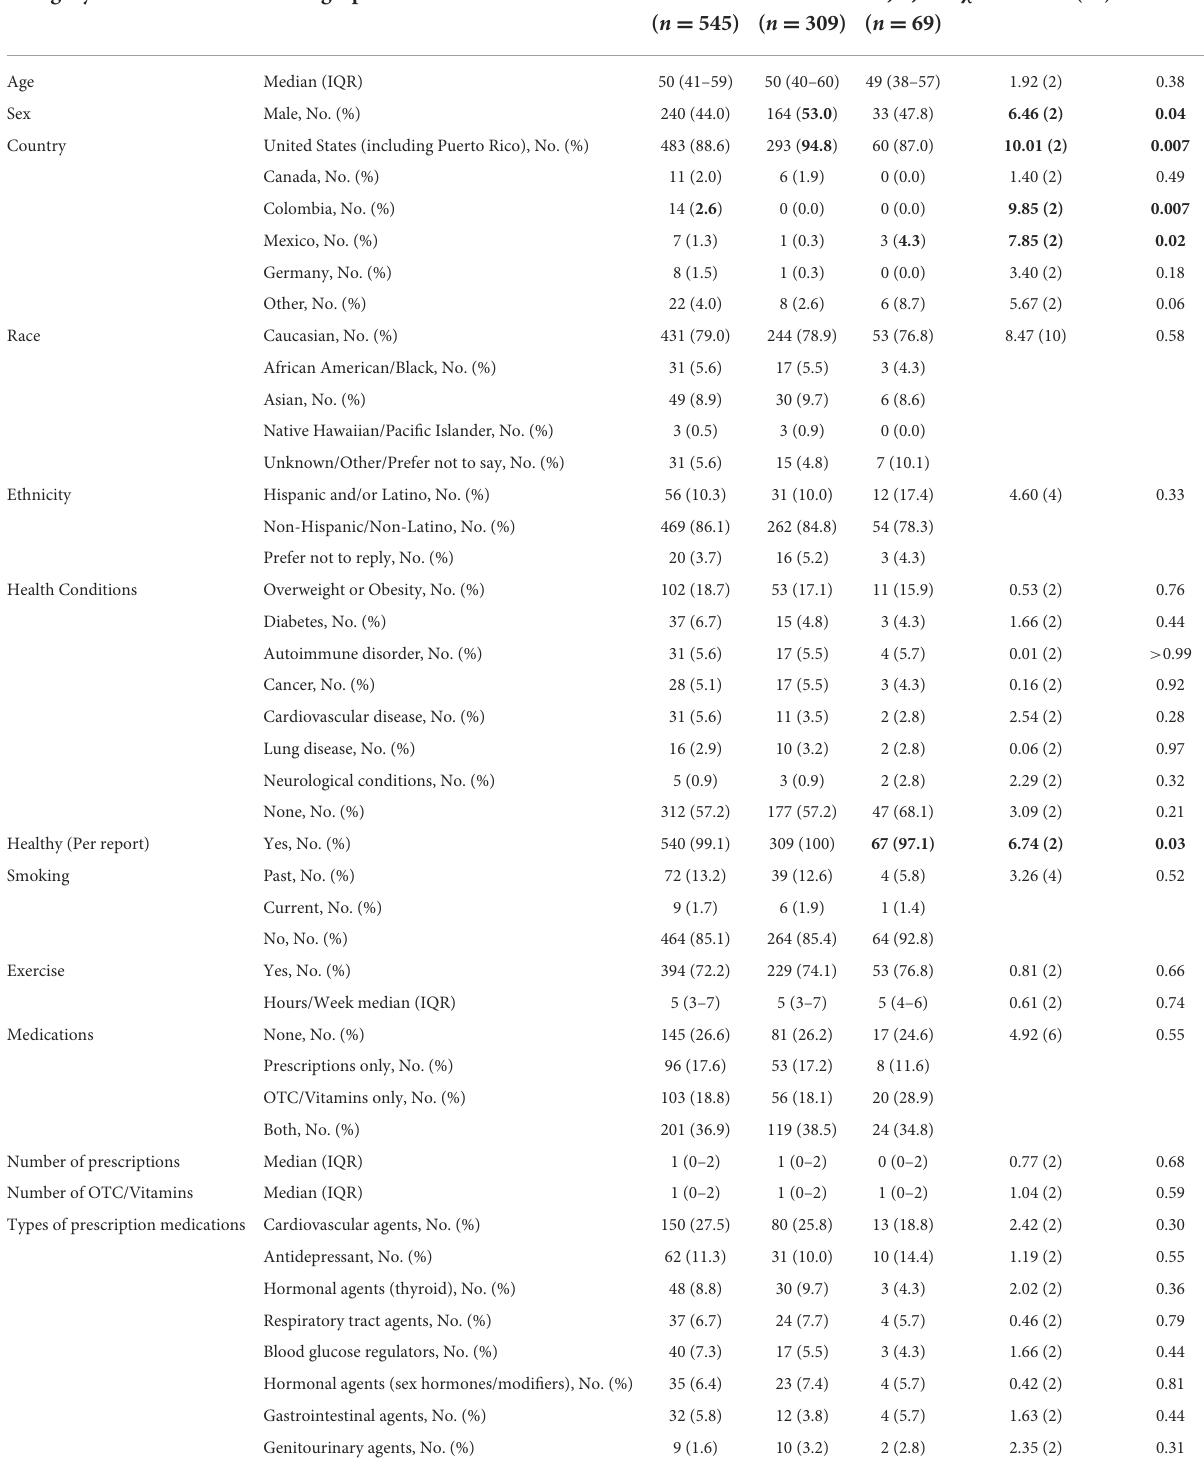
TABLE 2 Participant demographics and health conditions by vaccine